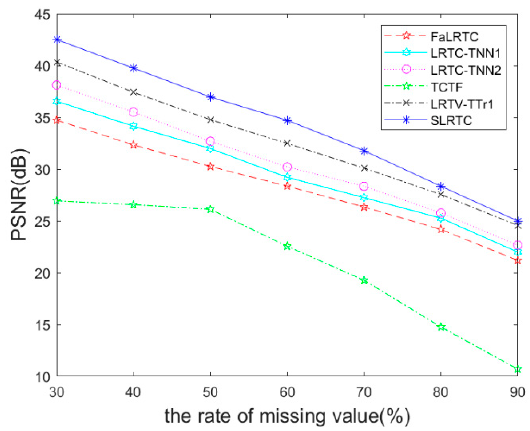
Figure 16. The PSNR metric on video data recovery.